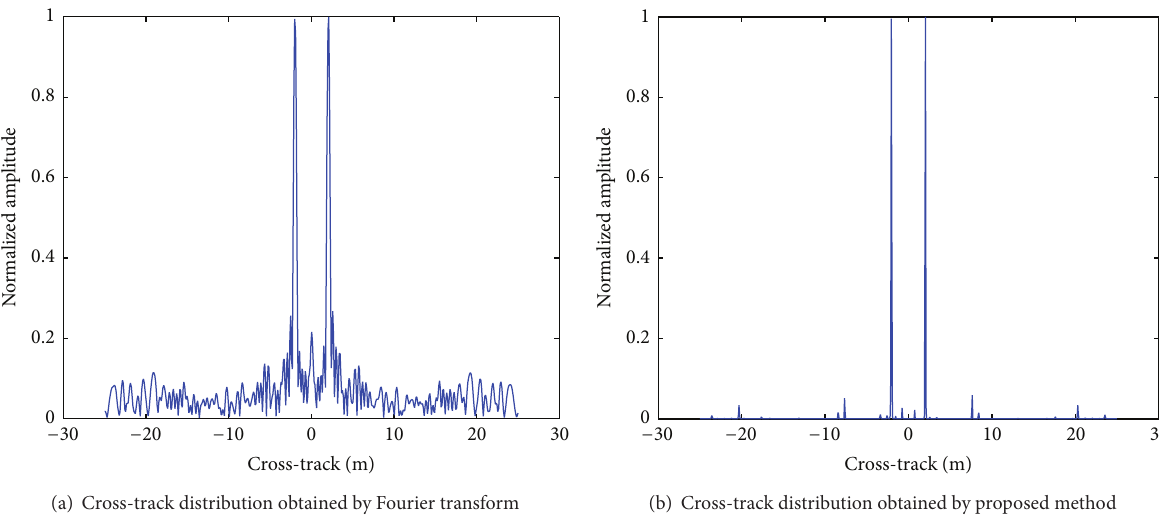
Figure 7: Comparison of the cross-track distribution obtained by Fourier transform and the proposed